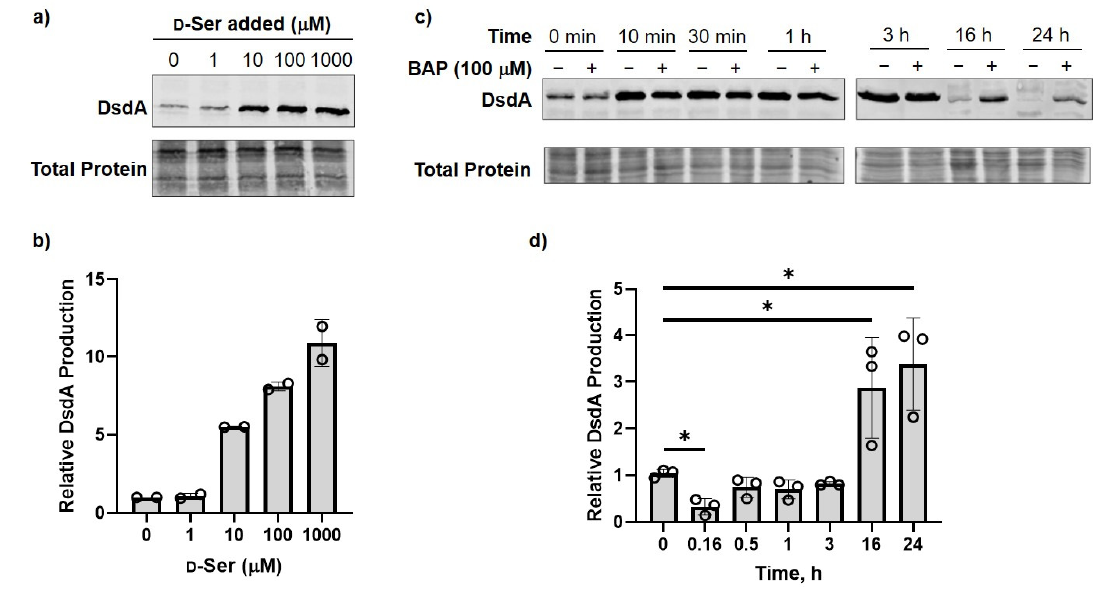
Figure 4. DsdA production in response to D -Ser, or BAP exposure in the presence of D -Ser. ( a ) Representative Western blot analysis showing that DsdA production increases in the presence of added D -Ser in MOPS-glycerol; ( b ) Quanti fi ed DsdA levels relative to 0 µM D -Ser added ( n = 2, error bars represent standard deviation); ( c ) Representative Western blot analysis showing that enhanced, sustained DsdA production is observed in BAP-treated CFT073 over time; ( d ) Quanti fi ed DsdA levels in the presence of D -Ser under DXPS inhibition by BAP relative to the (-) BAP control at respective timepoints; n = 3, error bars represent standard deviation, data for all three replicates shown (). p > 0.05 (ns); p ≤ 0.05 (*); p ≤ 0.01 (**); p ≤ 0.001 (***)